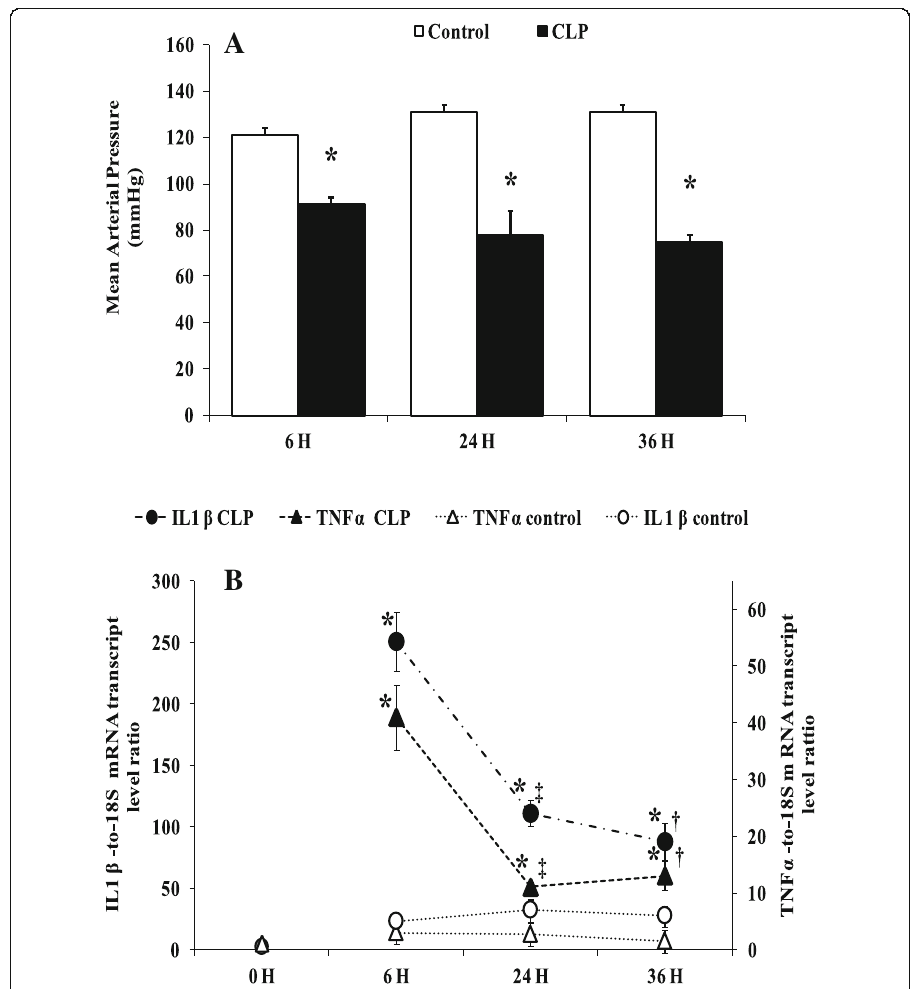
Fig. 1 Mean arterial pressure and cytokines mRNA levels. a Mean arterial blood pressure (MAP mmHg) at the end time point in matching sham-operated control groups (white bars) and CLP groups (black bars). Data are means±SEM. * p <0.05 versus matching sham-operated control from six animals per group determined by surgical procedure and following period (0, 6, 24, 36 h). b TNF α and IL 1 β mRNA level were determined by real-time quantitative PCR in the liver of control groups (naïve and sham operated) (white symbols) and CLP groups (black symbols). Data are means±SEM. * p <0.05 versus control (matching sham operated and naïve); ‡ p <0.05 compared 6 h CLP and 24 h CLP; † p <0.05 compared 6 h CLP and 36 h CLP, from five animals per group determined by surgical procedure and following period (0, 6, 24, 36 h)